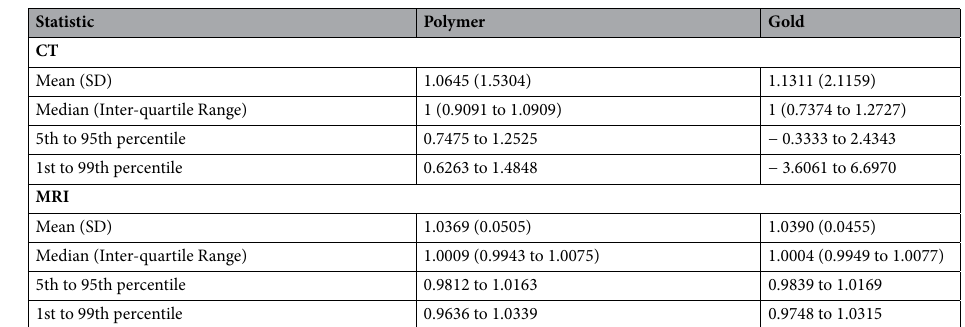
Table 1. A statistical comparison of the relative gray-scale histograms (where the phantom normal tissue gray-scale was normalized to 1) of the polymer versus gold fiducials, generated from a 50 mm square centered on the fiducial for CT and MRI imaging. The mean (SD standard deviation), median, and percentile ranges highlight and contrast the artifact’s effect on the more uniform phantom gray-scale.